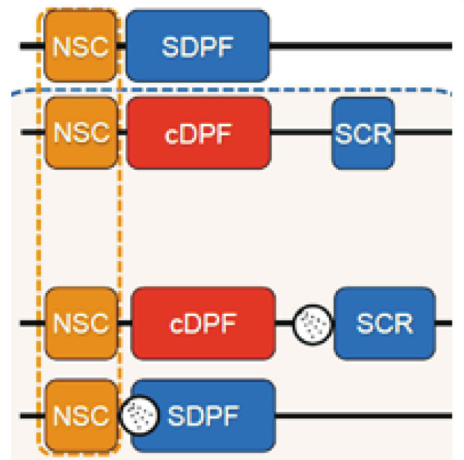
Fig. 6. Some of the LDD aftertreatment system designs for Euro 6c (RDE) [12]